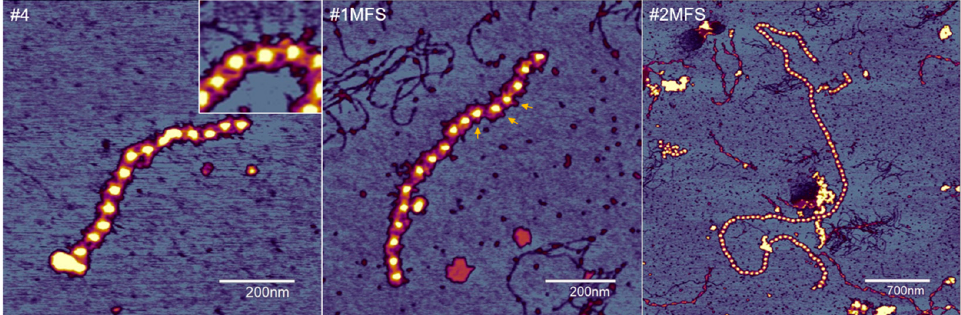
Figure 2. Atomic force microscopy of fibrillin microfibrils purified from MFS and non-MFS human aortic tissues; #4 is a control sample, and #1MFS and #2MFS refer to the respective mutations. The microfibrils displayed a conserved morphology but were of various lengths irrespective of the sample of origin. A characteristic “beads-on-a-string” aspect dominates the topography, in which the beads are interconnected by filamentous interbeads. As pictured in the inset, the interbeads were often visible in the form of two or three filamentous arms connecting the beads. Additionally, lateral filaments (arms) emerging from the surface of some of the beads could also be observed (yellow arrows).